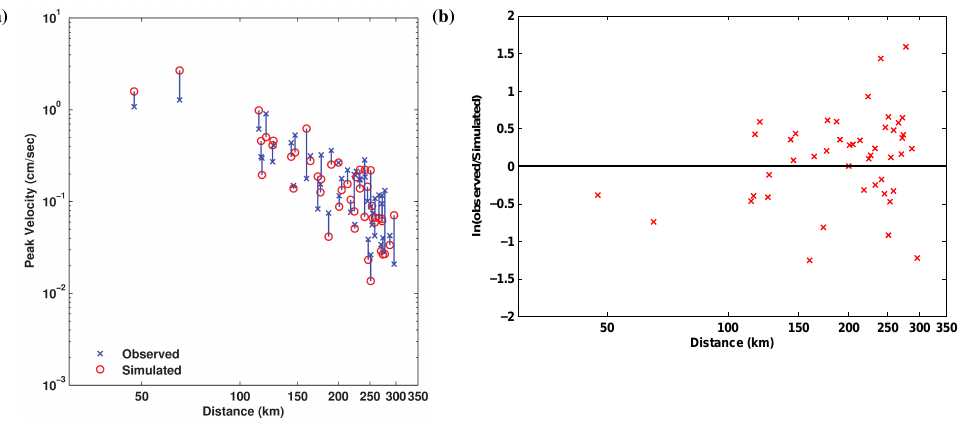
Figure 18. (a) Comparisons of peak ground velocity (PGV) of the high-frequency content of the simulated and the observed ground motions during the 2004 Parkfield earthquake as a function of station distance. (b) Natural log of the residual of simulated and recorded values.